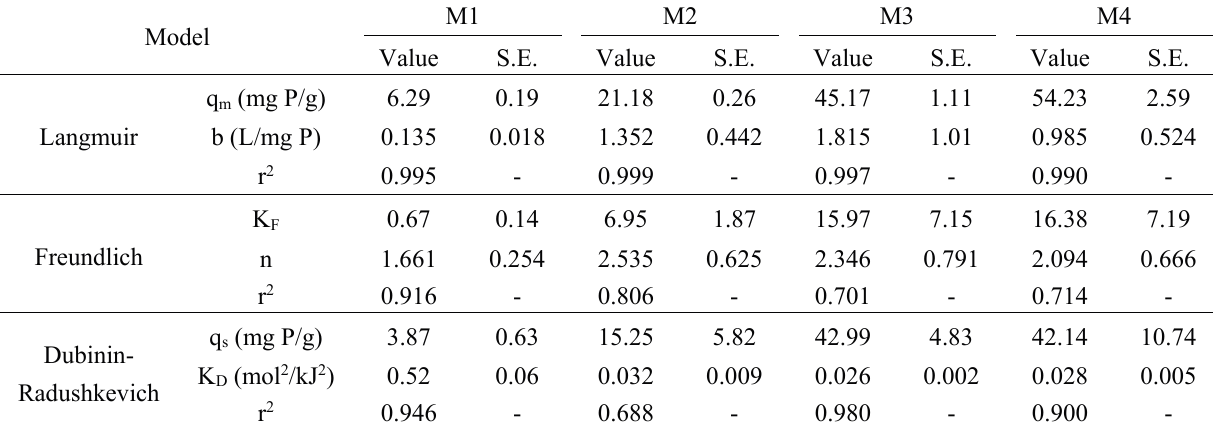
Table 4. Langmuir, Freundlich and Dubinin-Radushkevich isotherm parameters obtained by linear fitting for the four adsorbents (M1, M2, M3 and M4).